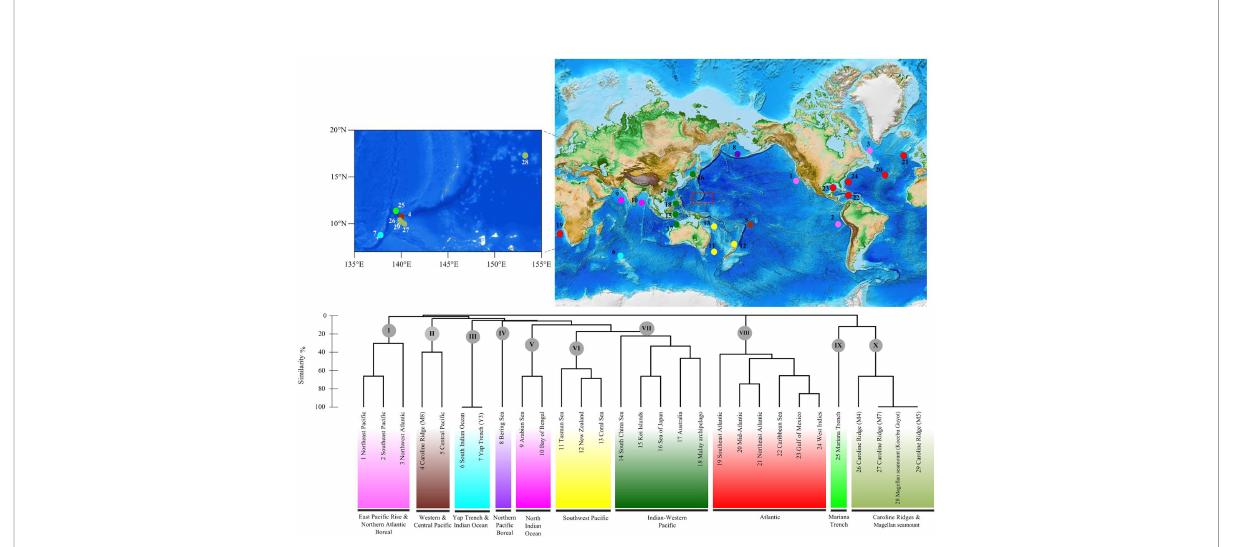
FIGURE 14 Geographical clustering of the 29 deep-sea fi elds studied based on the unweighted pair group method with arithmetic mean (UPGMA) cluster analysis (Bray – Curtis distance) and an 10-province model based on the data of deep-sea echinothuriid